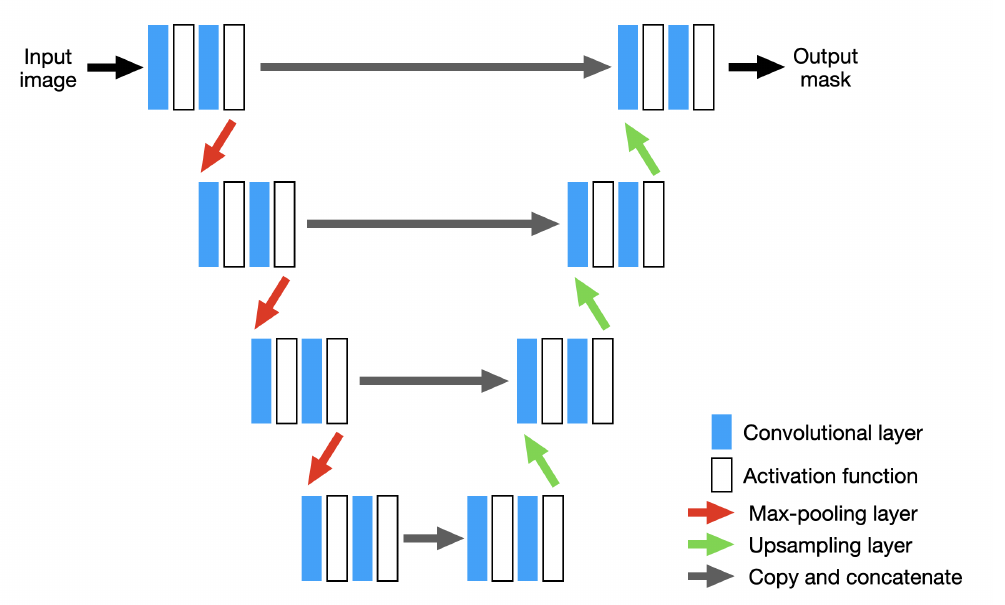
Figure 5. U-Net architecture using 3 × 3 convolutional layers and ReLU activation functions. Filter depths of each level are given in Table